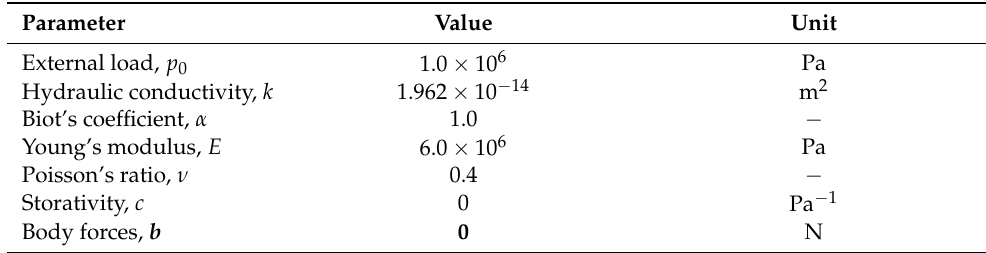
Table 1. Terzaghi’s problem: Load and material parameters.